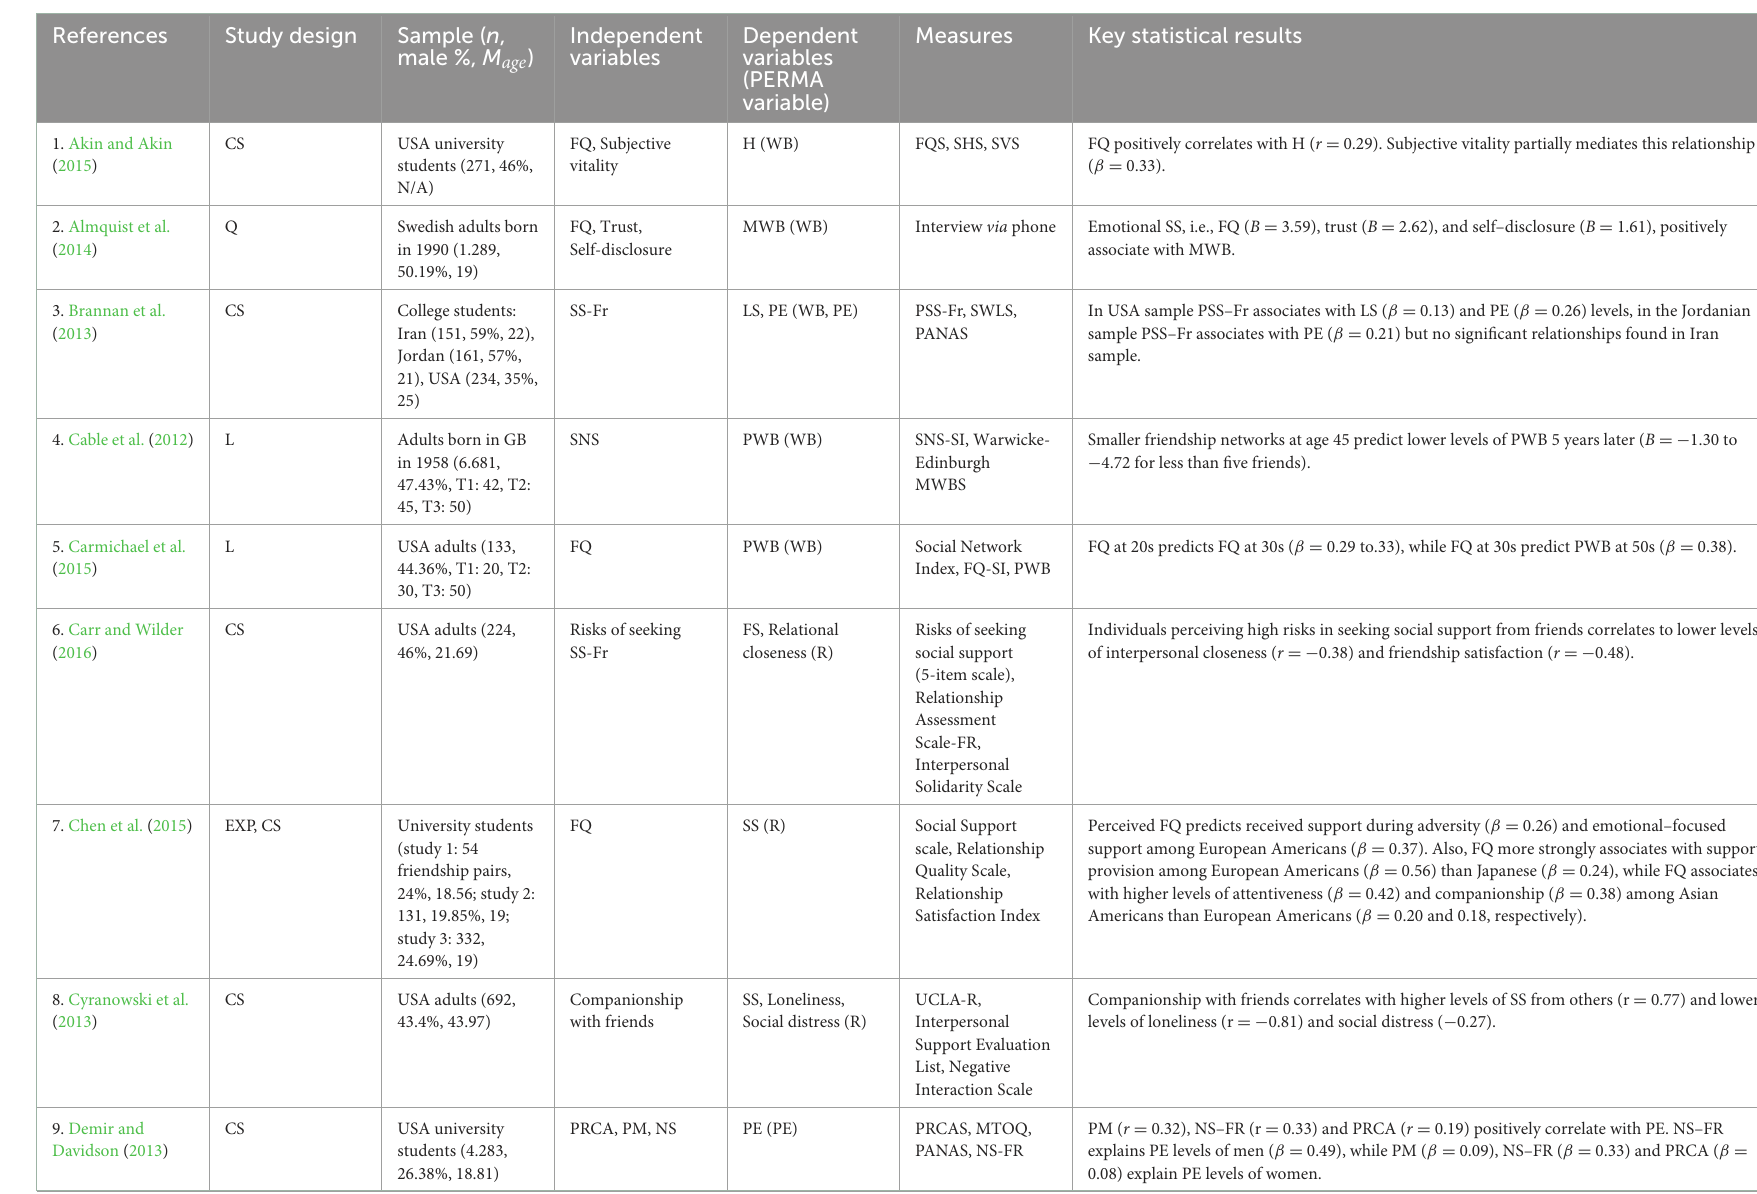
TABLE 1 Findings of the systematic literature review regarding the associations between adult friendship and